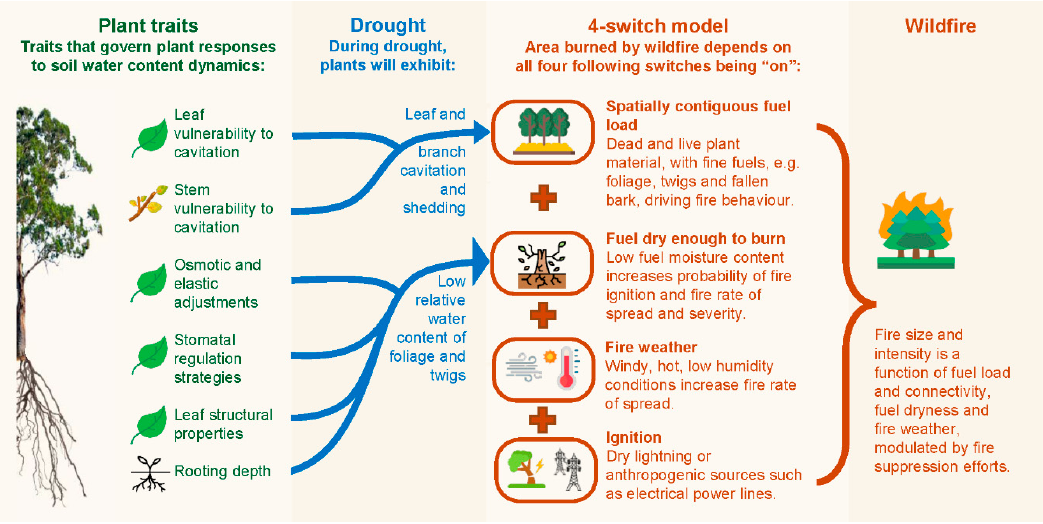
Figure 1. Conceptual model illustrating linkages between drought-related plant traits and the likelihood of wildfire. The 4-switch model is outlined in Bradstock [14].